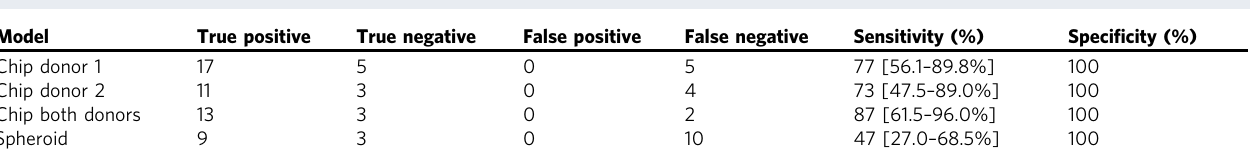
Table 6 Sensitivity and speci fi city